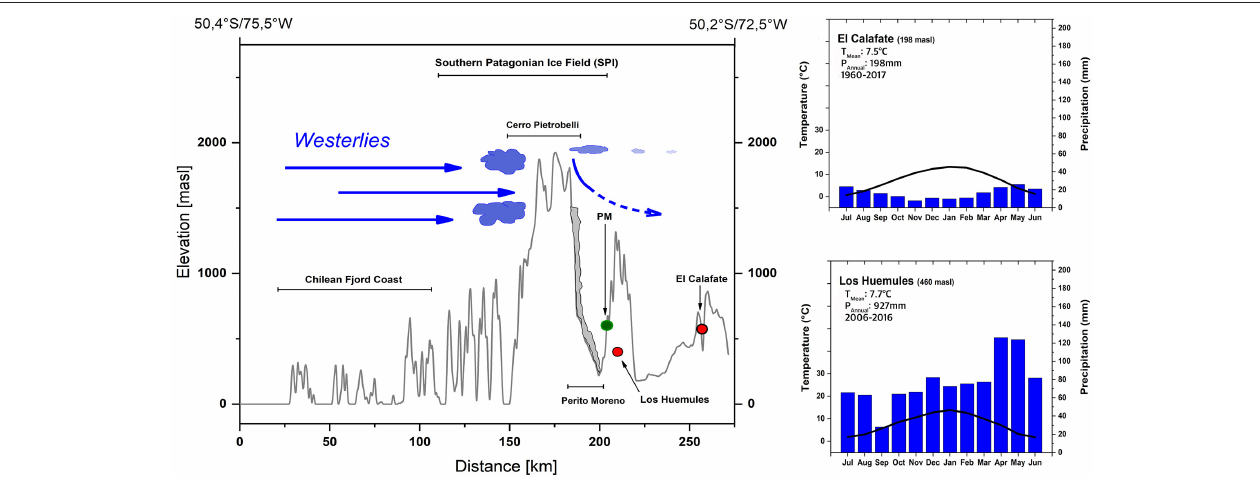
FIGURE 5 | (Left) Elevation profile from the Pacific Ocean across the Andes and the Southern Patagonian Ice Field to El Calafate. Green circle indicates geographical setting of the sampling site at Perito Moreno Glacier southern lateral moraine (PM). Red circles indicate location of the AWS in El Calafate and the comparable geographical location (elevation, distance from main Andean ridge) of the AWS in Los Huemules. (Right) Climate diagrams of meteorological stations in El Calafate and Estancia Los Huemules.